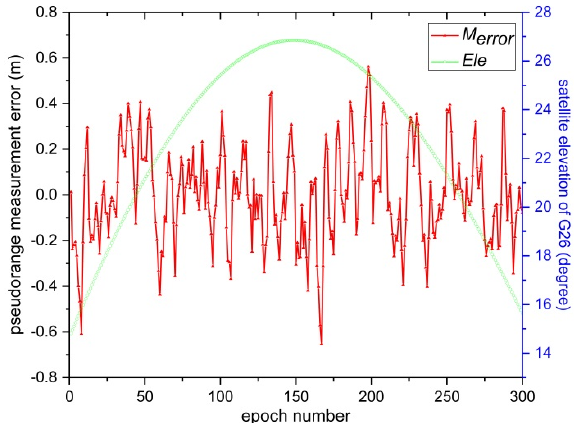
Figure 8. Elevation and pseudorange measurement error sequence of satellite G26.